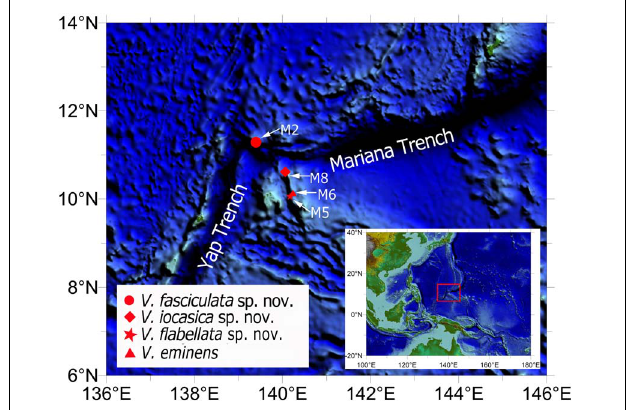
FIGURE 1 | Sampling sites of the studied Victorgorgia spp. from seamounts in the tropical Western